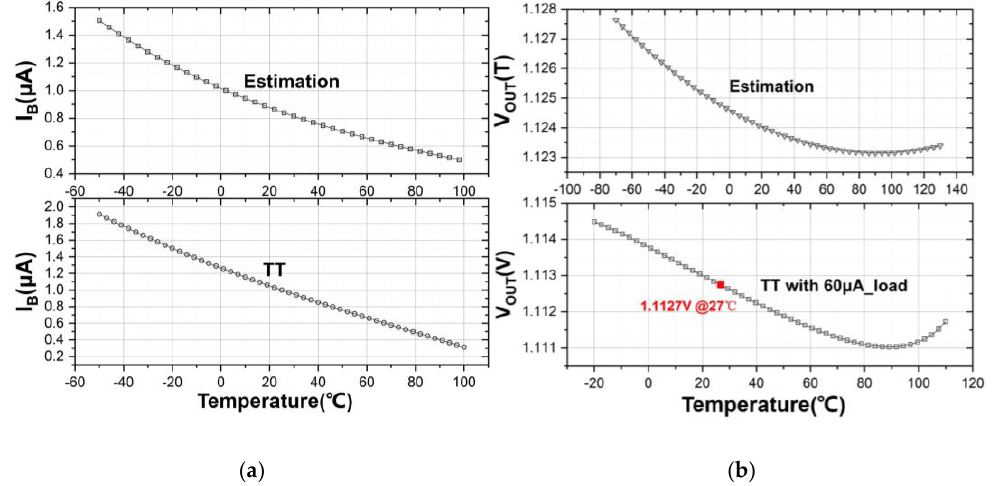
Figure 10. Comparison between theoretical predictions and simulation results under typical case of ( a ) I B (T) ; ( b ) V OUT (T).